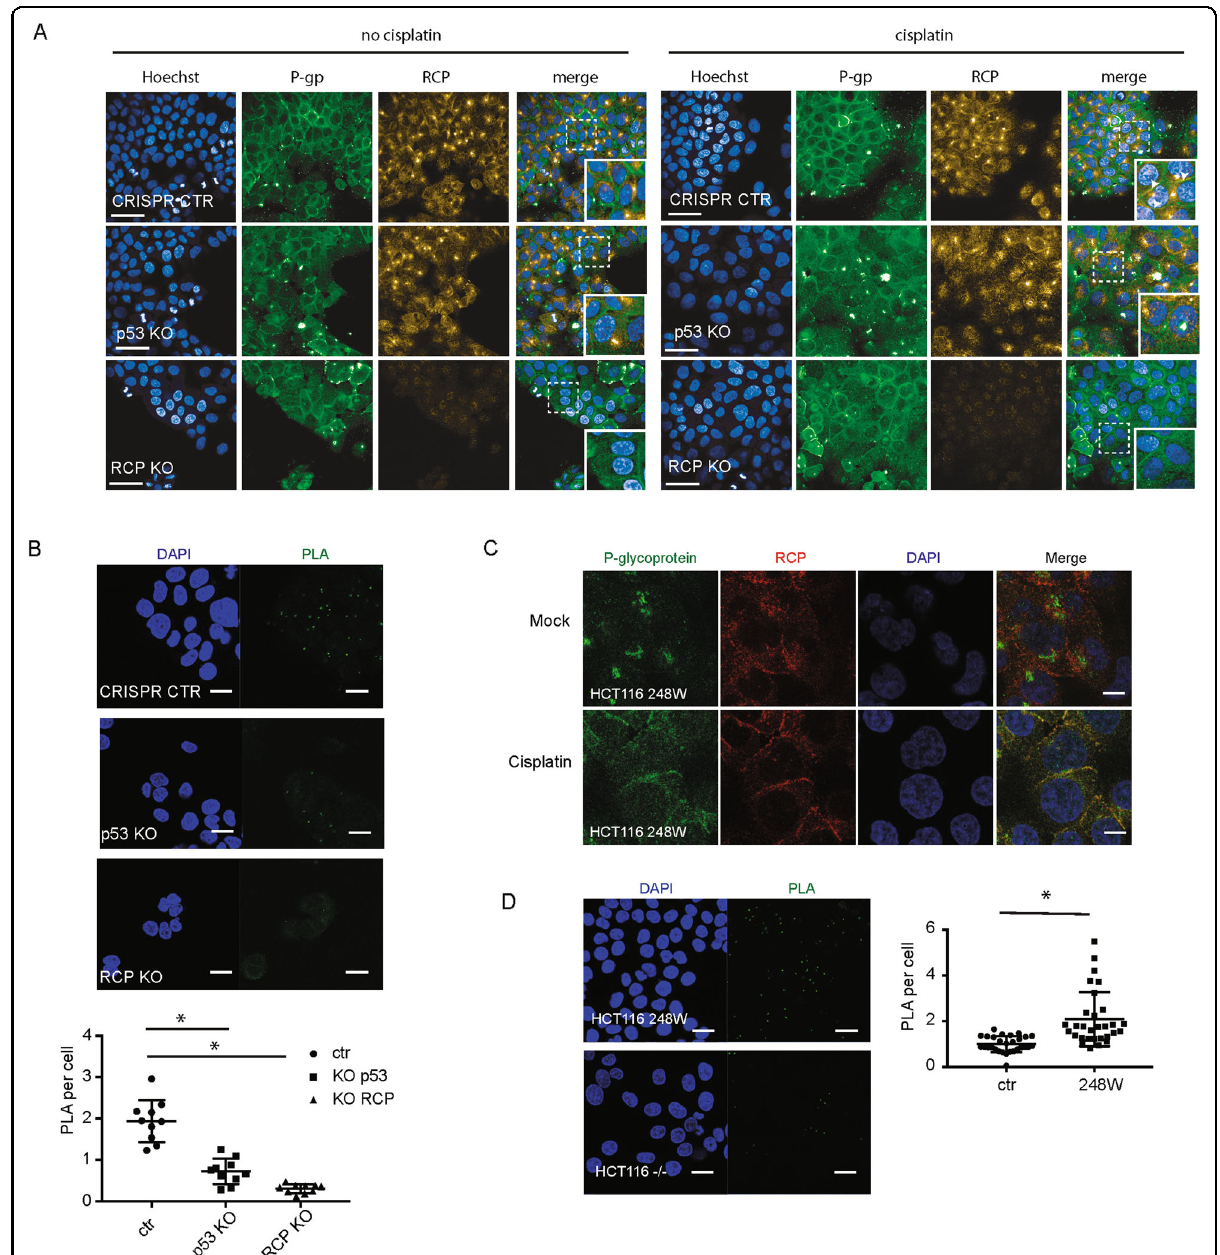
Fig. 4 Mutant p53 promotes RCP and P-gp co-localisation. A A431 ctr1, A431 RCP KO and A431 p53 KO cells were grown on coverslips and treated with cisplatin 6.7 µM for 2 h. Localisation of endogenous P-gp and RCP was determined with confocal microscopy using antibodies speci fi c for P-gp (Invitrogen Ab, green) and RCP (red). Scale bars are 20 µm. B Proximity ligation assays (PLA) in A431 CRISPR control, RCP KO and p53 KO. Images were taken by confocal microscopy (top). Scale bars are 20 µm. The PLA signal was quanti fi ed as dots/nucleus for all the cells and plotted in a box and whiskers plot (bottom). Statistical differences were measured using a one-way ANOVA, multiple testing corrected P < 0.00001 for both, two- sided. Error bars indicate SD of average values of three independent experiments (three repeats per experiment). C HCT116 248W cells were grown on coverslips and treated with cisplatin 6.7 µM for 2 h. Localisation of endogenous P-gp and RCP was determined with confocal microscopy using antibodies speci fi c for P-gp (Santa Cruz Ab, green) and RCP (red). D Images (left) and quanti fi cation (right) of PLA in HCT116 null and 248W cells with the antibodies speci fi c against P-gp and RCP. Statistical differences were measured using a t -test, P < 0.00001, two-sided. Error bars indicate SD of average values of three independent experiments (three repeats per experiment).